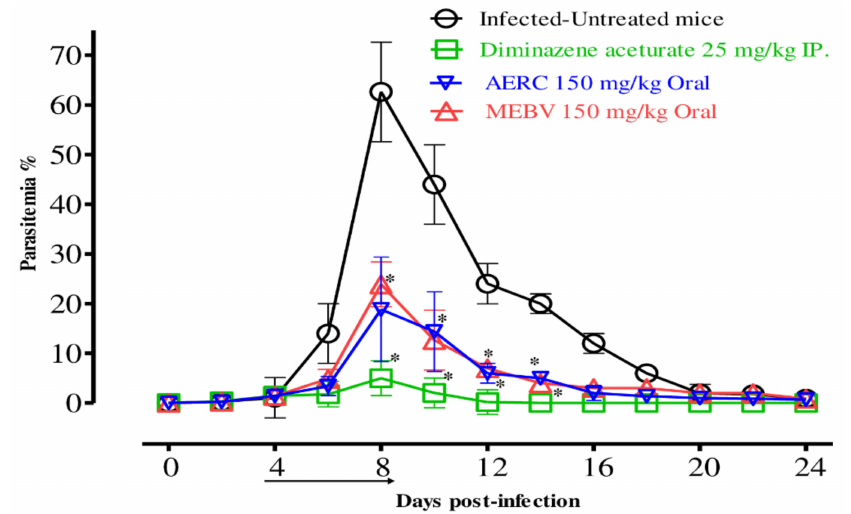
Figure 4. Growth inhibition e ff ect of MEBV and AERC treatment against B. microti in vivo. The arrow indicates 5 consecutive days of treatment start from day 4 to 8 p.i. Asterisks indicate statistically significant ( p < 0.05) di ff erences of parasitemia between treated groups and the untreated group based on unpaired t -test analysis. Parasitemia was detected using Giemsa-stained thin blood smears by counting infected RBCs (iRBCs) among 2000